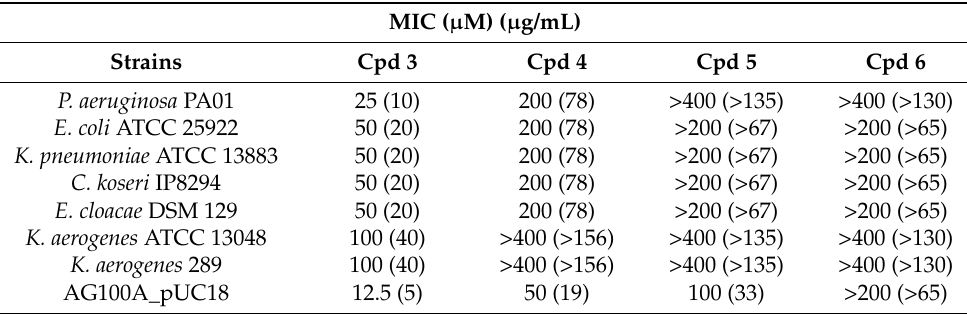
Table 2. Minimum Inhibitory Concentrations of polyaminoisoprenyl derivatives 3 – 6 against various Gram-negative bacterial strains.